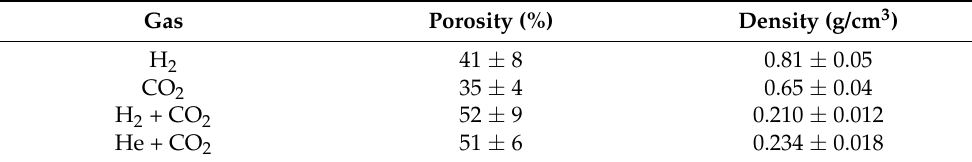
Figure 6. SEM-microphotographs Cu/CS gel samples (low molecular weight chitosan, molar ratio Cu/CS = 1/5) modified with ( a ) H 2 (1 MPa) and CO 2 (30 MPa); ( b ) He (1 MPa) and CO 2 (30 MPa); ( c ) saturated with H 2 (1 MPa); ( d ) Histogram of distribution of pore sizes in sample ( a ); ( e ) Histogram of distribution of pore sizes in sample ( b ); ( f ) SEM-micrograph Cu/CS gel sample saturated with CO 2 (30 MPa). Table 2. Densities and porosities of modified Cu/CS lyophilized hydrogels.